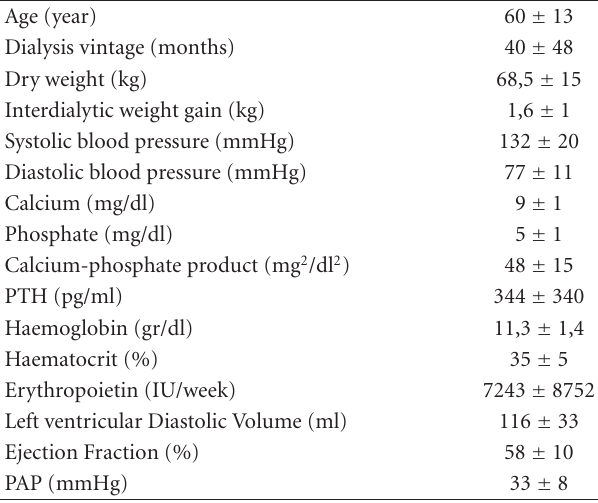
Table 1: Data describing the 56 patients in whom pulmonary artery pressure was